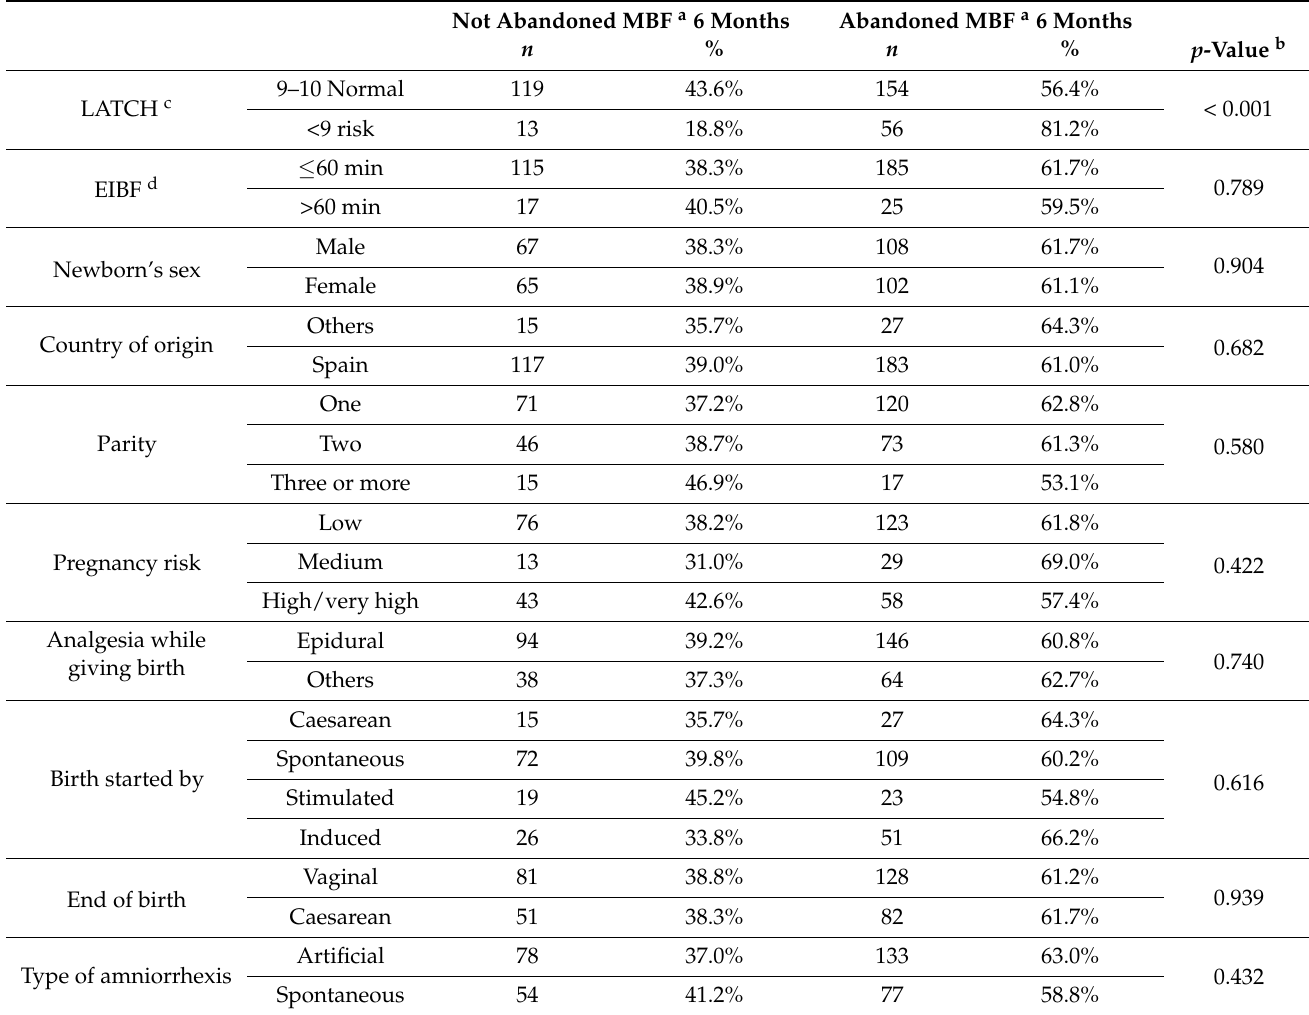
Table 3. Abandoning exclusive breastfeeding at 6 months postpartum ( n = 342).